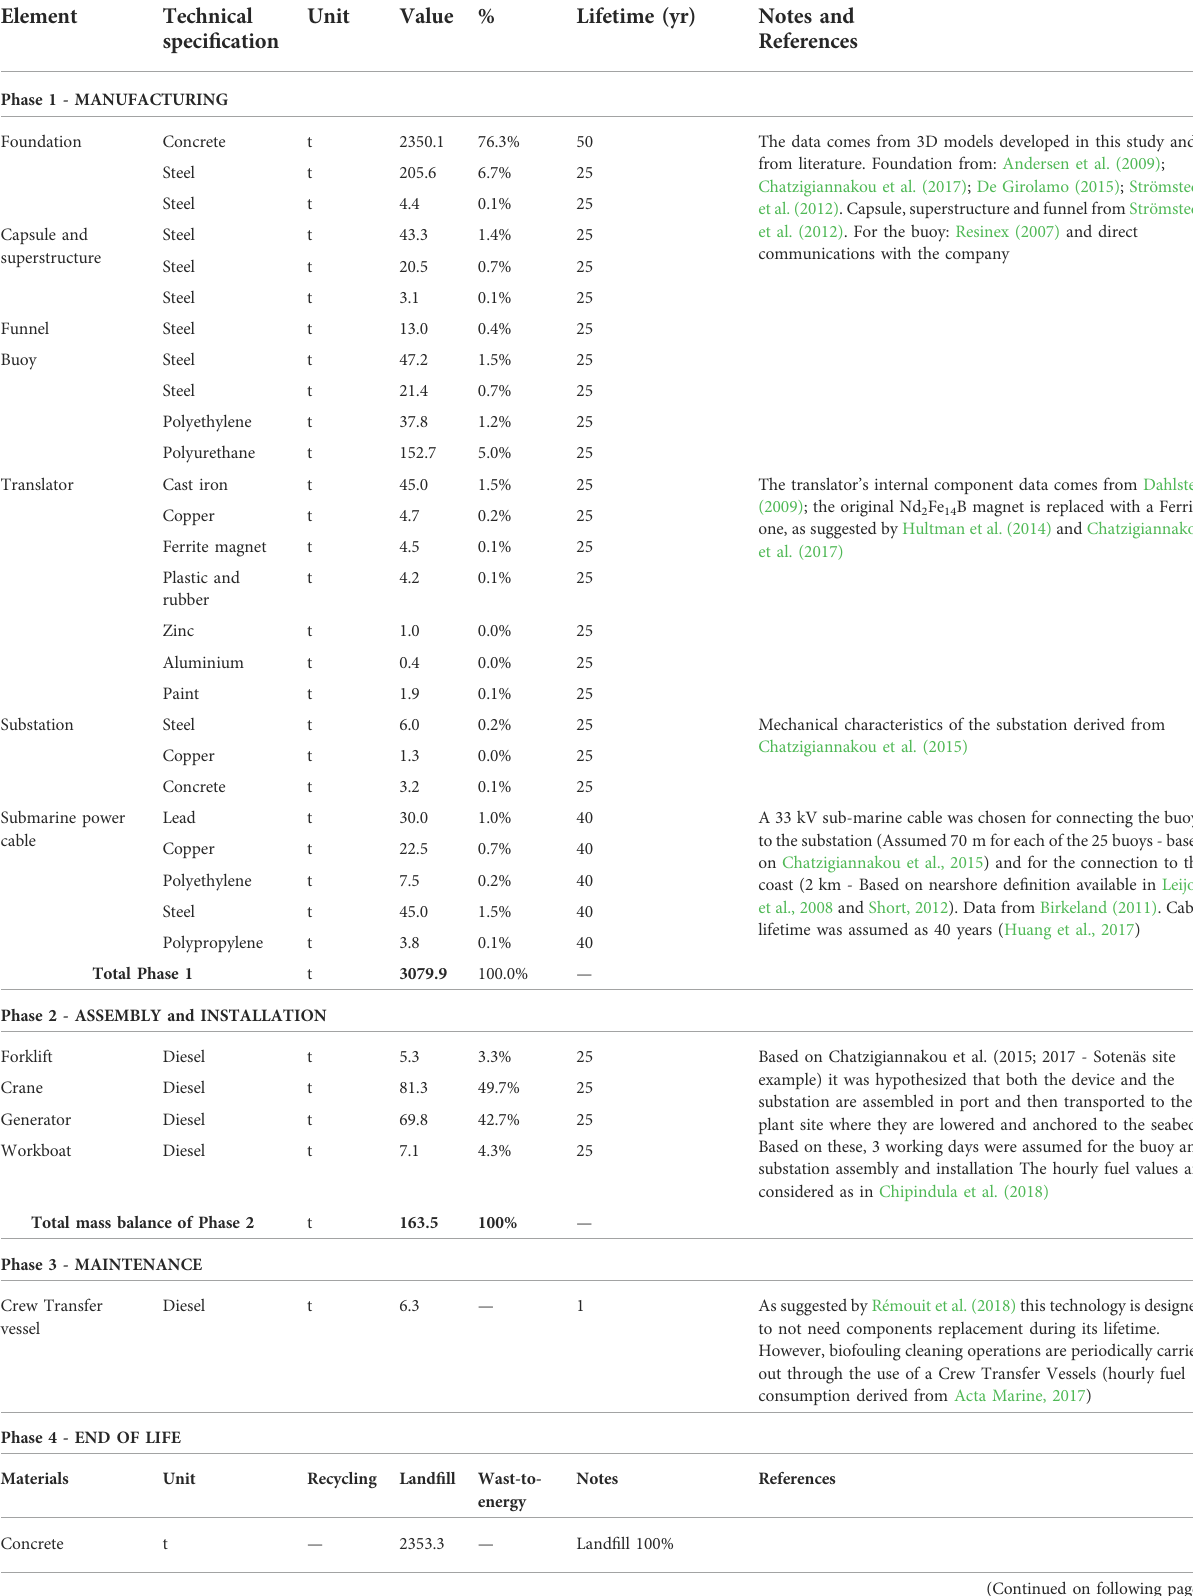
TABLE 4 Life Cycle Inventory data for a wave park hosting 25 generic seabed-based buoys. Values in bold represent totals and subtotals.